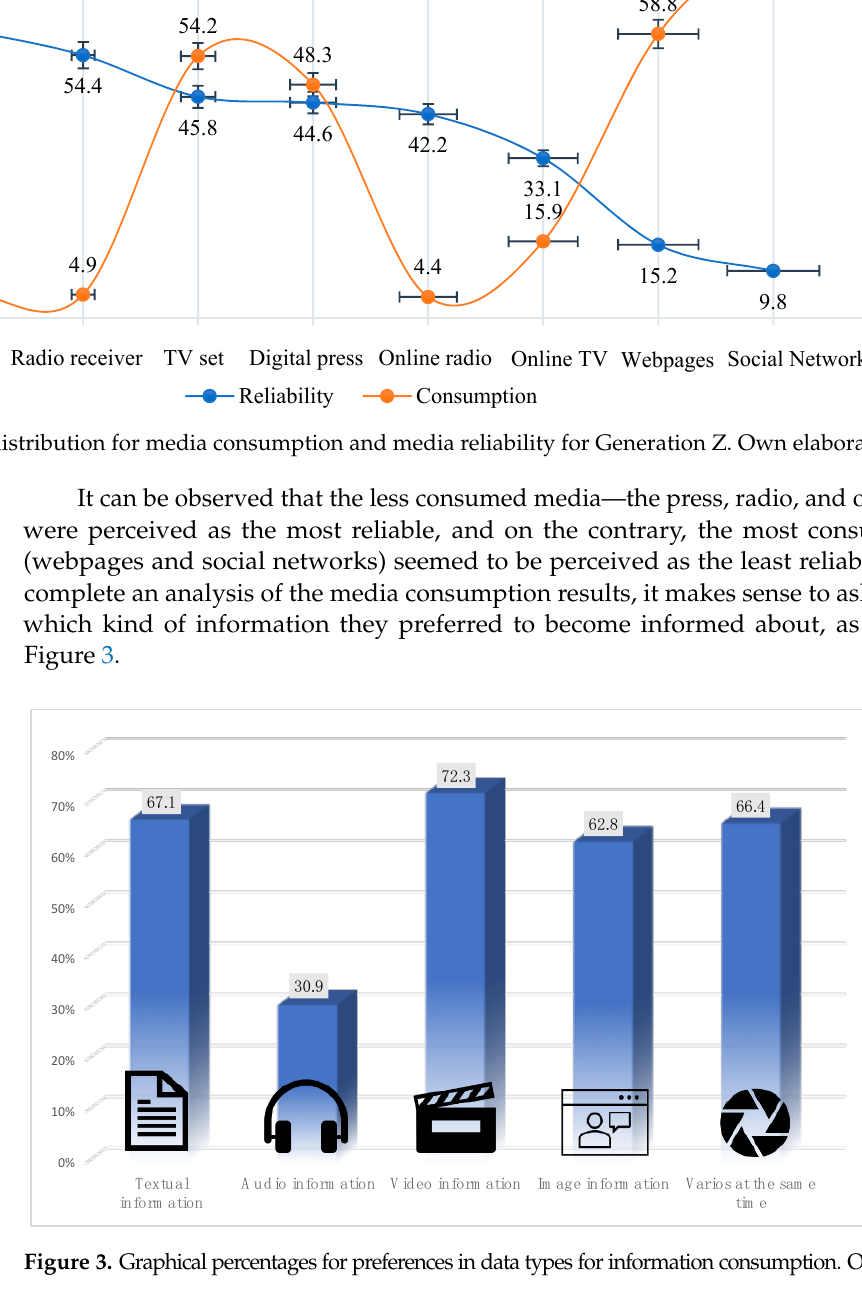
Table 4. Basic statistics for (V 4 ): what kind of information have consumed the most since COVID-19 occurred? Own elaboration.